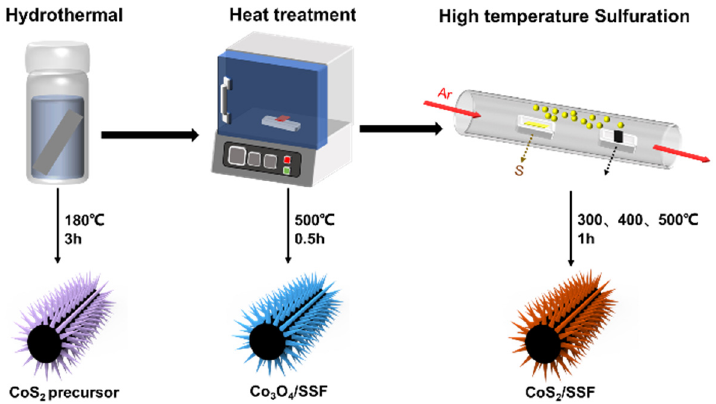
Figure 6. A schematic diagram of the preparation process of the CoS 2 NWs.